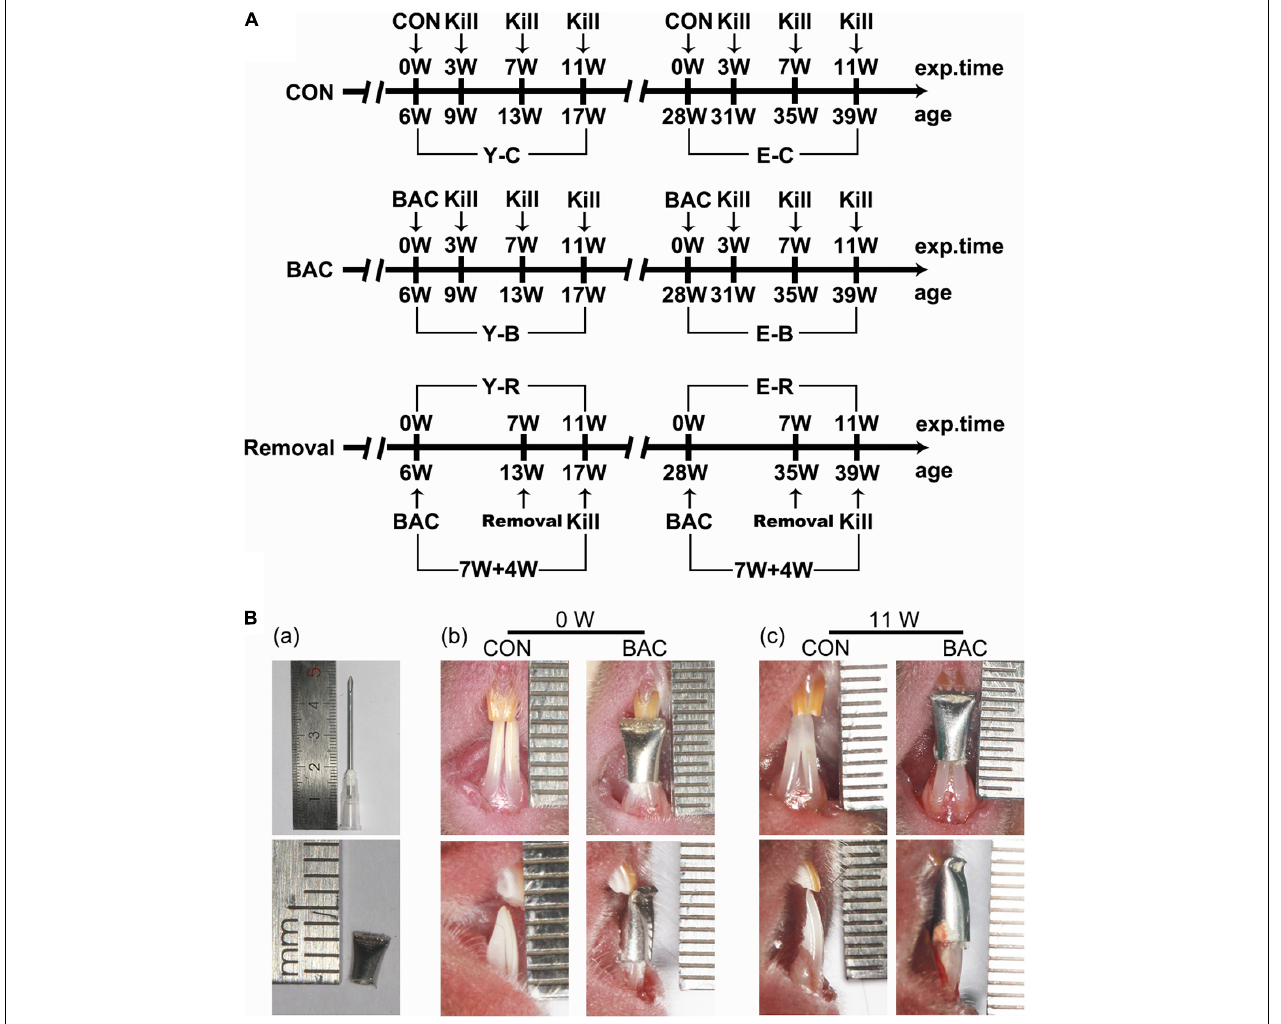
FIGURE 1 | (A) The timeline of the entire experiment. (B) Representative pinhead and the pinhead produced metal tube (a) used to change the bite of incisors, and frontal views of the incisors in the younger groups with and without the tubed bilateral anterior crossbite (BAC) relationship at 0 week (b) and 11 weeks (c) after modeling. exp. Time, experimental time point; age, the natural age of the mice; CON, control group; BAC, bilateral anterior crossbite group; Removal, BAC removal group. Y-C, younger control group; Y-B, younger BAC group; Y-R, younger removal group; E-C, elder control group; E-B, elder BAC group; E-R, elder